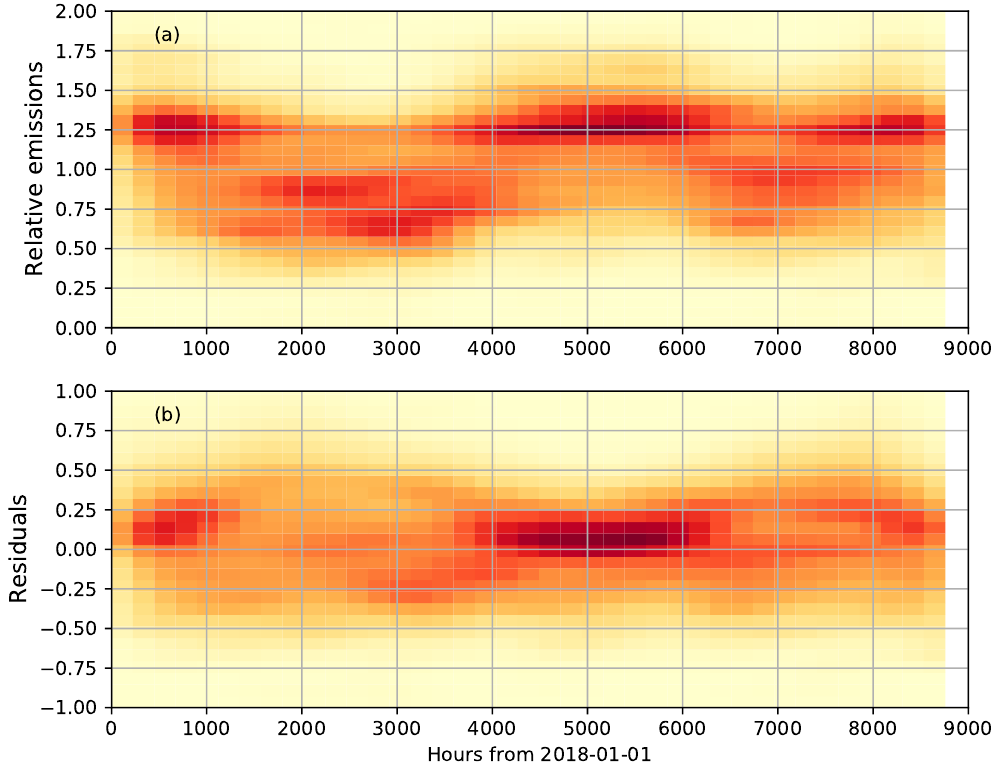
Figure 16. 2D histogram of relative hourly power plant emissions for 2018. ( a ) Relative emission data from all 50 plants, with no adjustments. ( b ) Difference between emissions with weekly and hourly factors removed and mean emissions, normalized by the mean emissions.